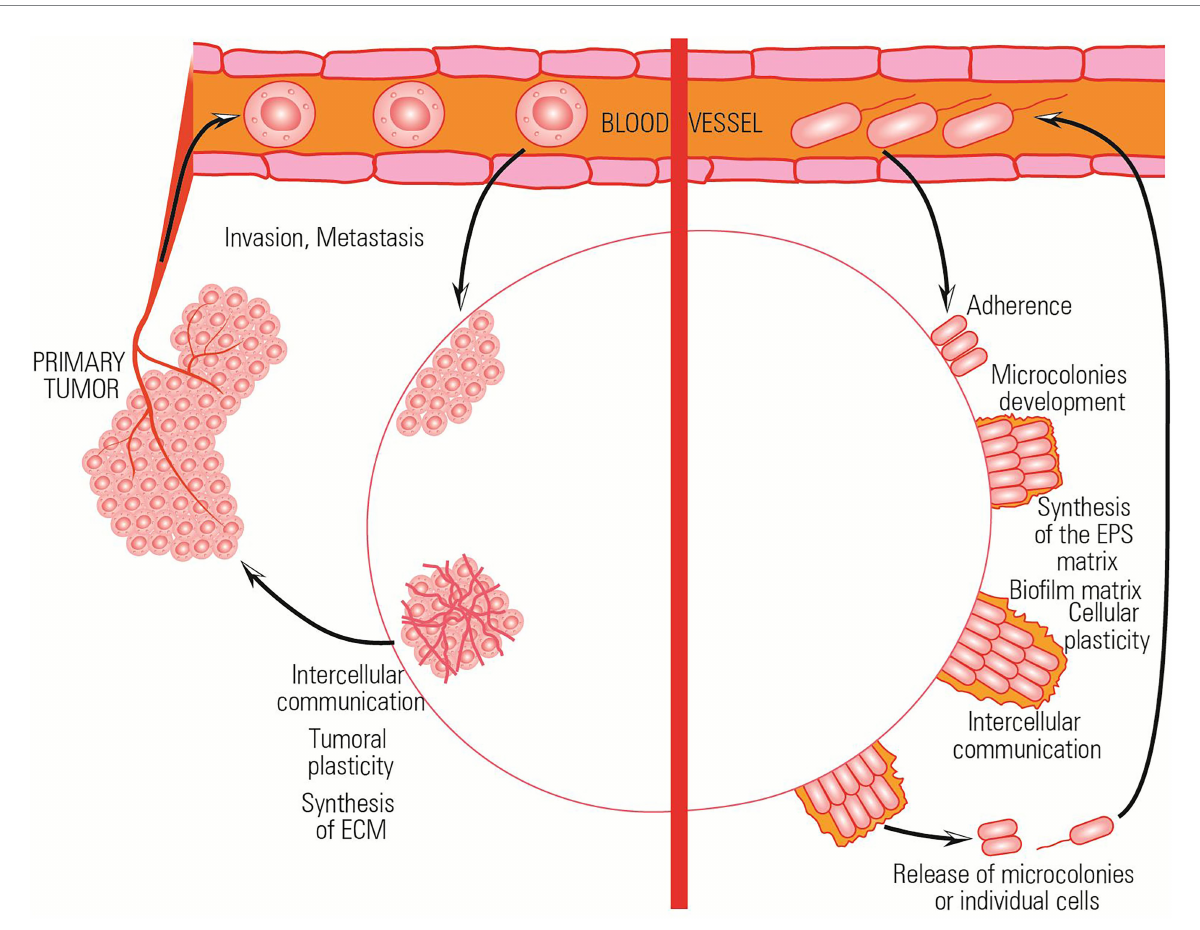
FIGURE 3 Comparative representation of the collective adaptative mechanisms exhibited by bacterial and tumor cells in stressful